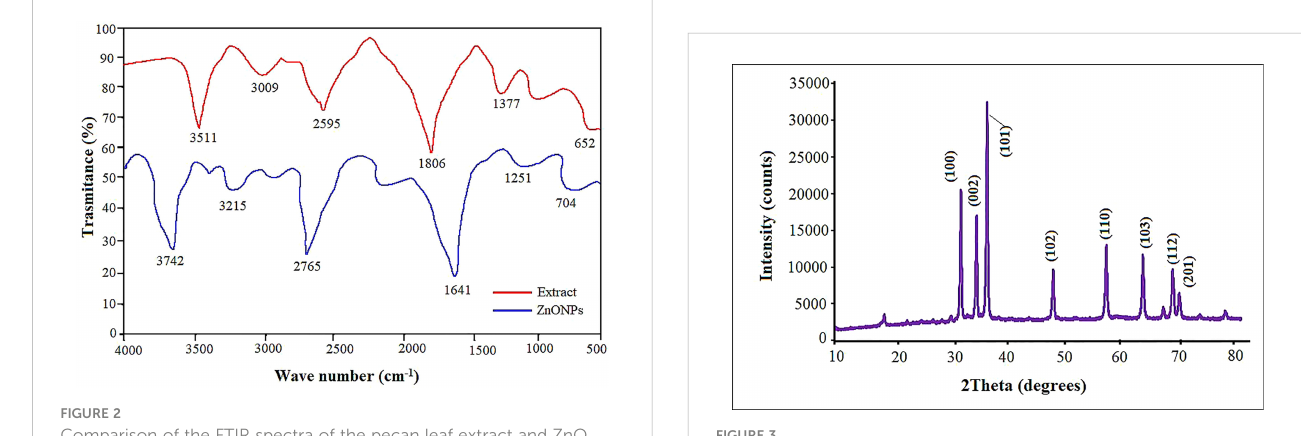
FIGURE 3 X-ray diffractometer patterns for biosynthesized ZnO NPs using pecan leaf extract.